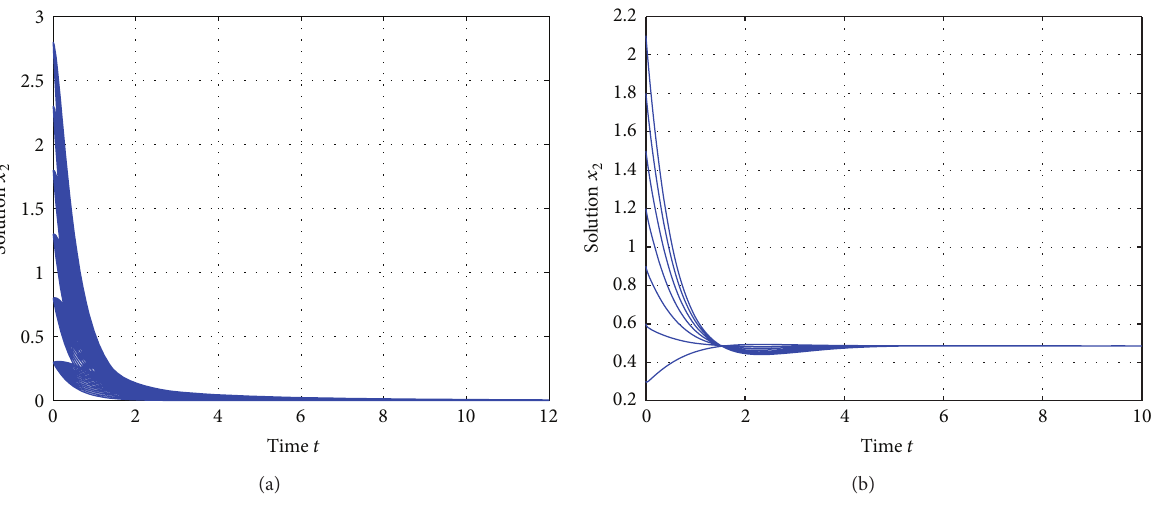
Figure 3: The trajectory of the predator 𝑥 2 of model (30) with (a) 𝑏 1 = 1.5 and 𝜏 = 0 ; (b) 𝑏 1 = 1.5 , 𝜏 ̸=0 , and 𝑥 𝑑 = (1.5,0.5) .